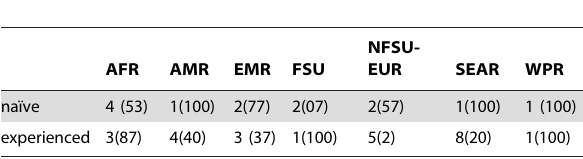
Table 5. Number of different structures that arose from 30 bootstrap samples fit to naı¨ve and treatment-experienced patients in each